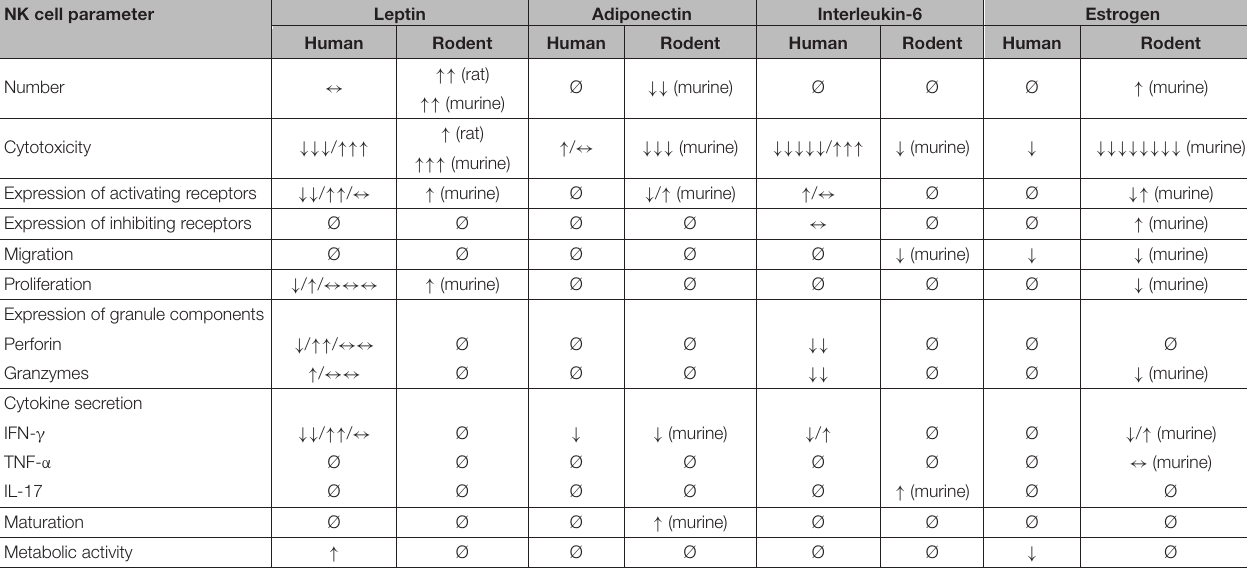
TABLE 2 | Effects of adipokine treatment on human and rodent natural killer cells. NK cell parameter Leptin Adiponectin Human Rodent Human Rodent Human Rodent Human Rodent Rodent Human Rodent Human Rodent Human